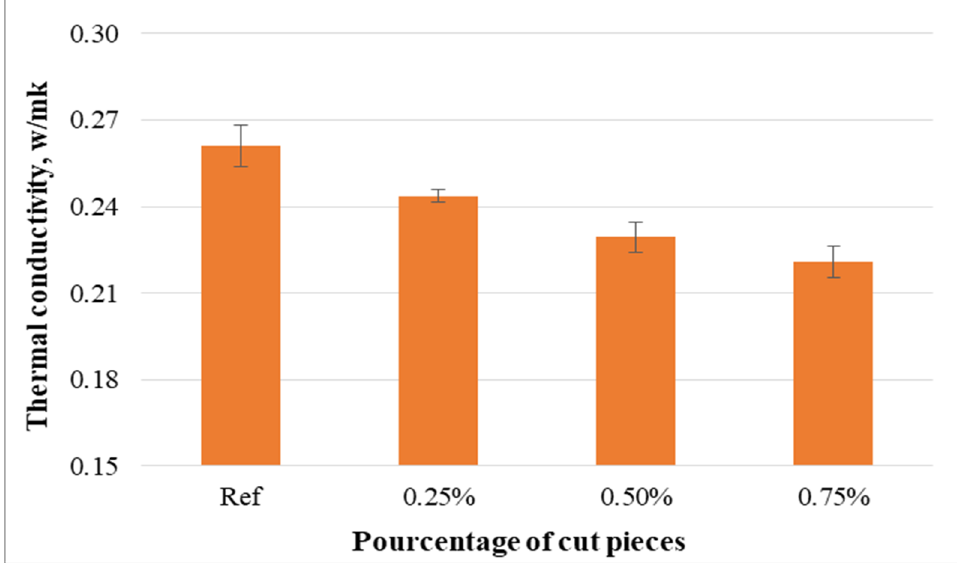
Figure 24. Thermal conductivity of concrete specimens containing cut pieces .